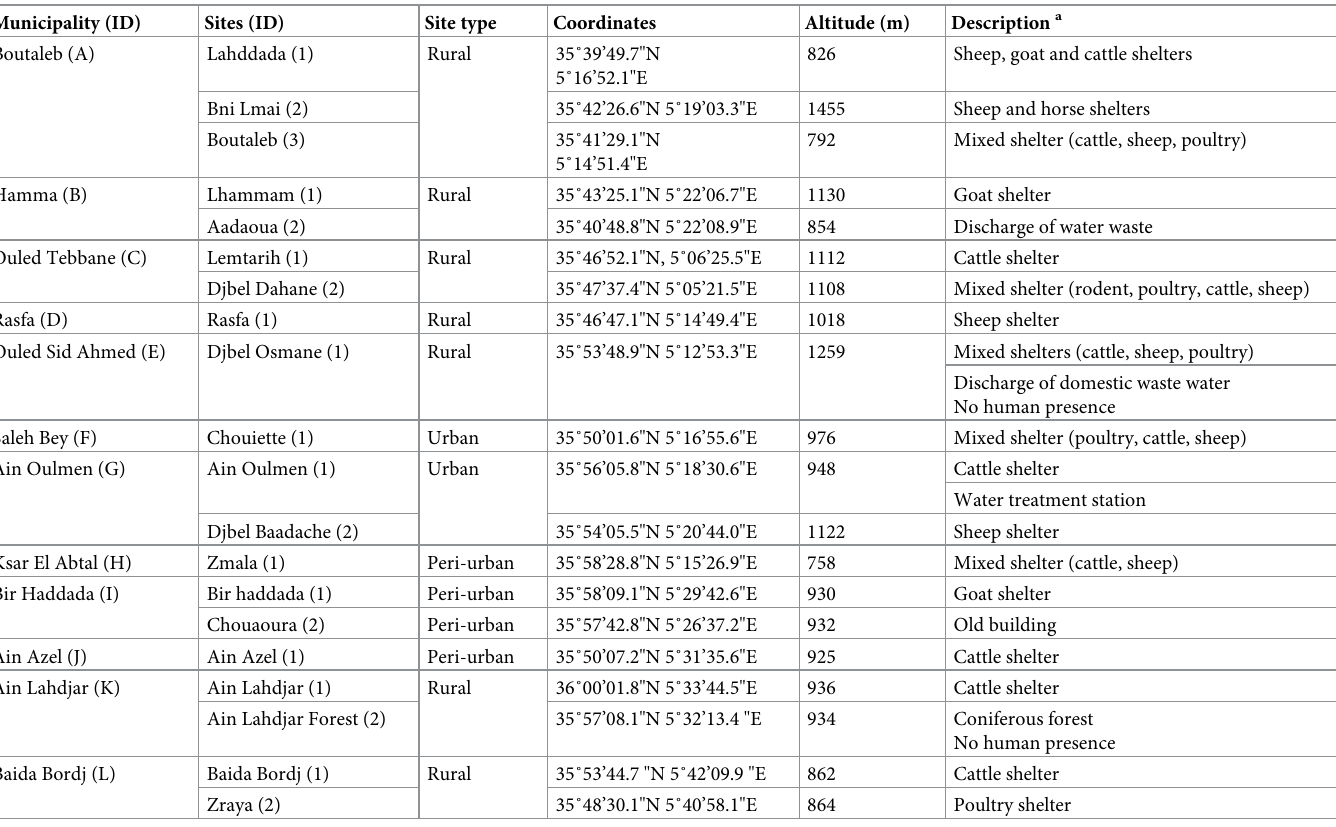
Table 1. Description of the phlebotomine sand fly collection sites in Setif province, Northeastern Algeria. The presence of animals and humans are also